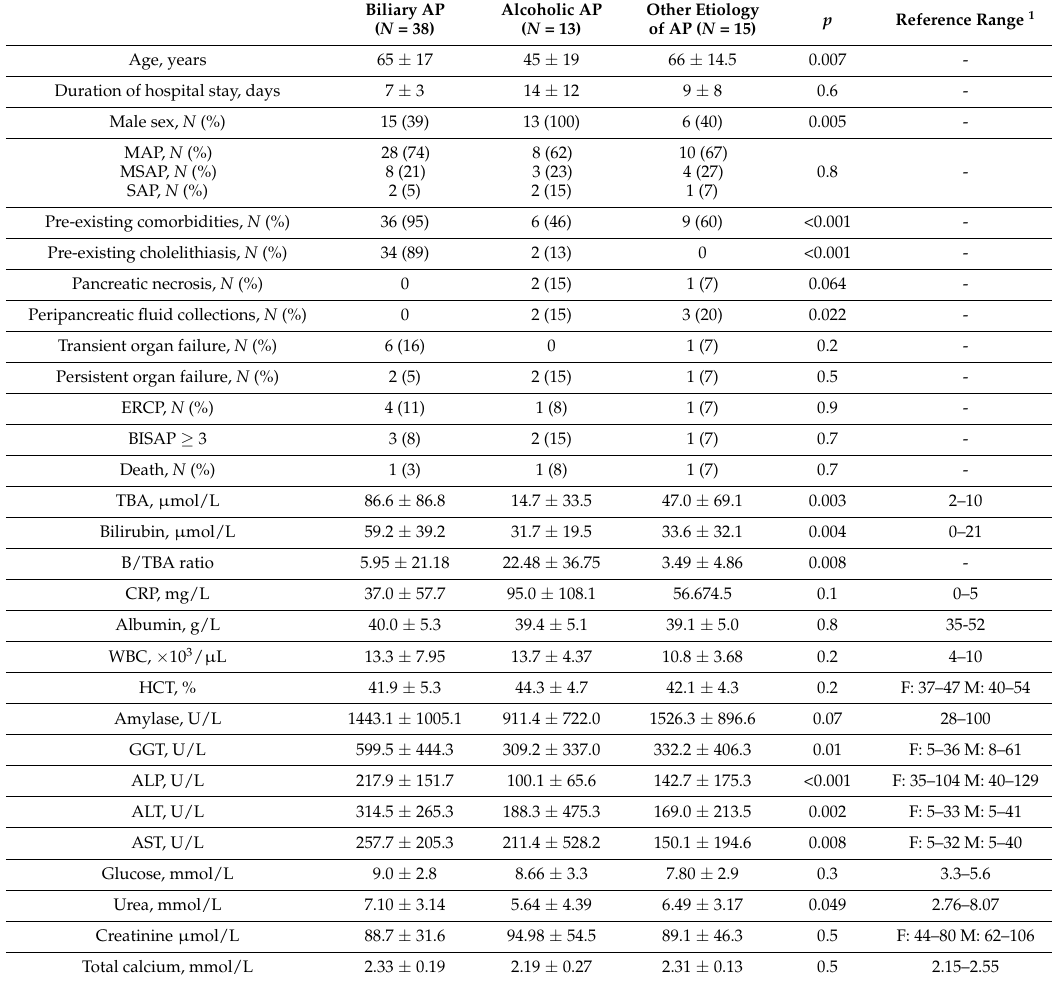
Table 1. Clinical characteristics of patients and the results of laboratory tests at 24 h from the onset of acute pancreatitis with respect to the etiology.